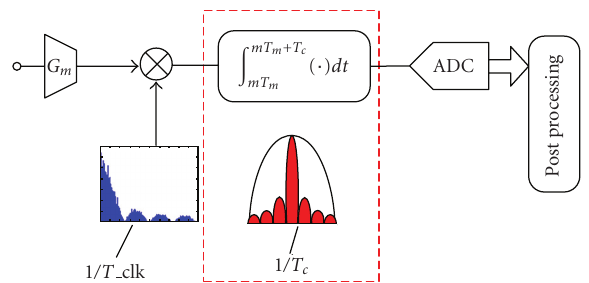
Figure 10: Macro model of one parallel